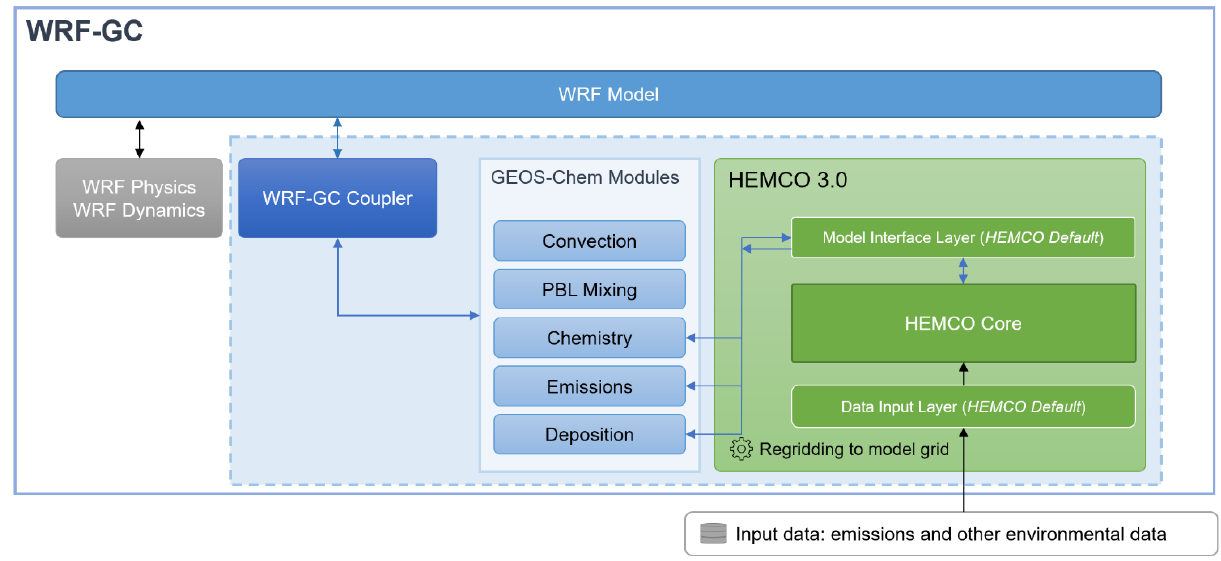
Figure 7. HEMCO 3.0 implementation in the WRF-GC model. The model is driven by WRF, which calls GEOS-Chem chemistry through the WRF-GC coupler. HEMCO 3.0 is implemented entirely as part of GEOS-Chem in WRF-GC, with each successive domain in the WRF model containing a separate instance of GEOS-Chem and HEMCO (dashed blue box). HEMCO interfaces with GEOS-Chem using the HEMCO default Model Interface Layer and reads data through the HEMCO default Data Input Layer using the same approach as GEOS- Chem Classic. Convection and PBL mixing are done by GEOS-Chem modules, but the driving meteorological data are provided by the WRF-GC coupler instead of through HEMCO, unlike in GEOS-Chem